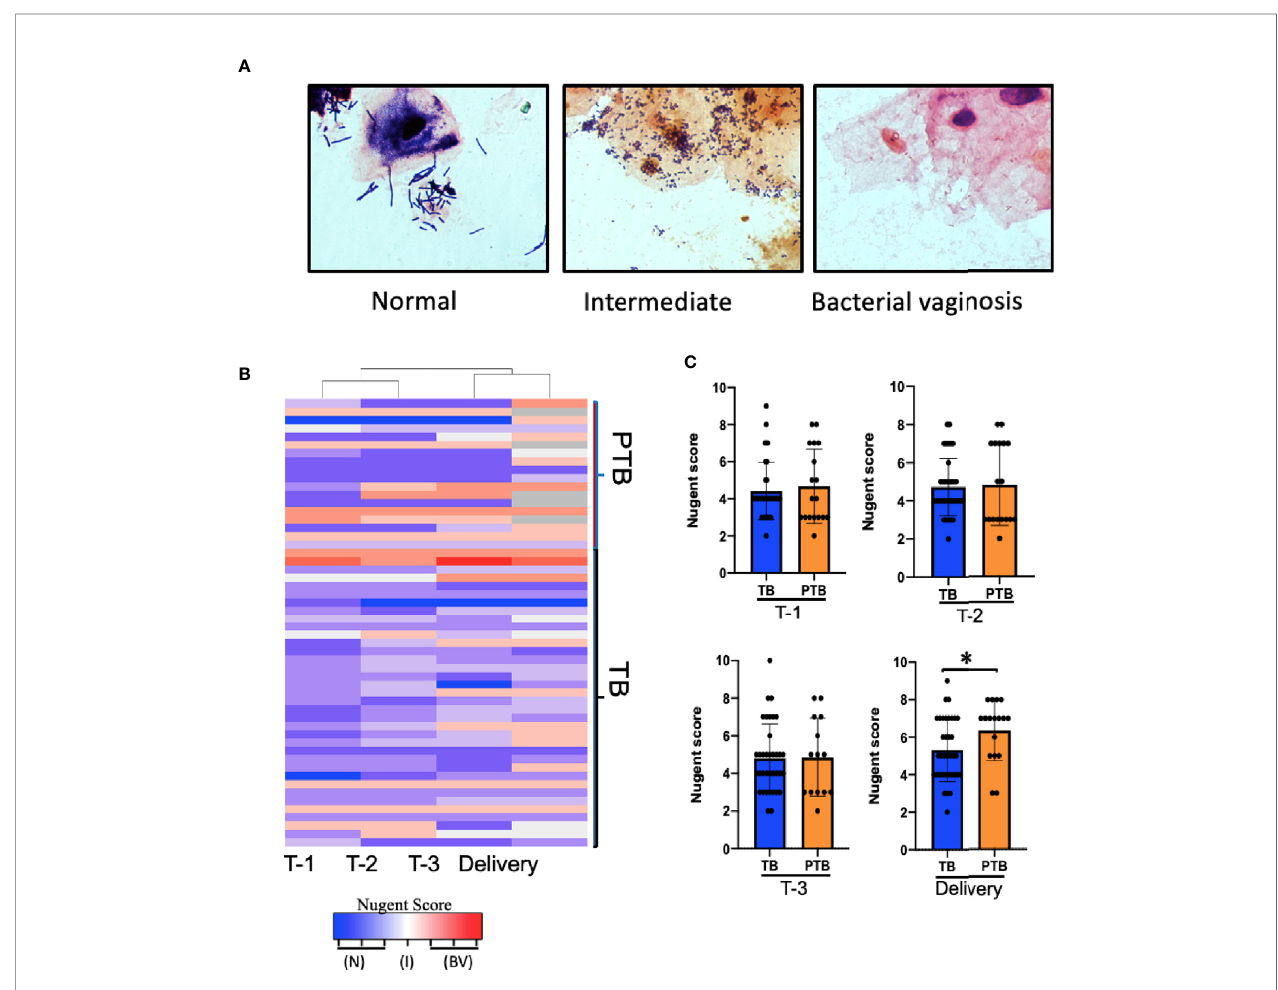
FIGURE 2 | Association between Nugent score and PTB. (A) Representative images of Gram-stained vaginal swabs with scoring normal, intermediate, and BV, Slides were evaluated under 1,000x magni fi cation according to the 10-point Nugent scale. (B) Heatmap showing the Nugent scores of individual women who delivered at term (TB) and women who experienced pre-term birth (PTB). Columns represent the trimester of pregnancy. Each row represents one subject. (C) Comparison of the average Nugent score in the TB or PTB groups during pregnancy. P -value was calculated using unpaired t -test (two-tailed) with Welch ’ s correction for difference in Nugent score between TB and PTB groups. * p < 0.05. T-1: Trimester-1, T-2: Trimester-2; T-3: Trimester-3; N, Normal; I, Intermediate; BV, Bacterial